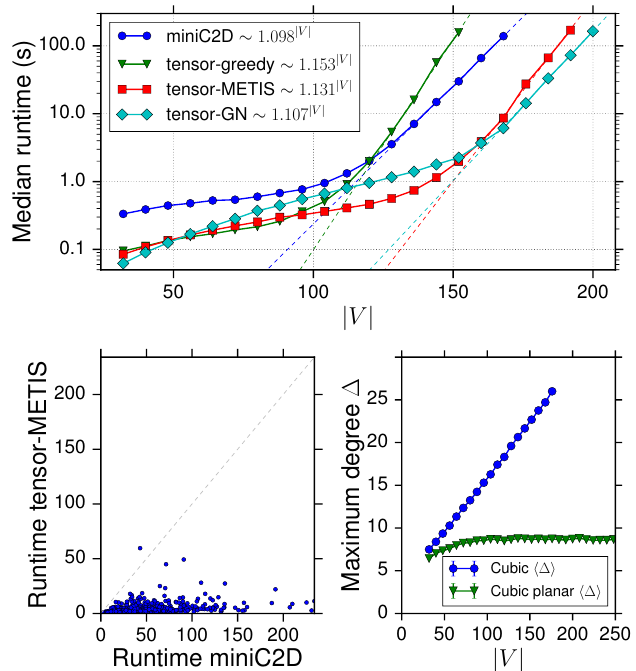
Figure 4: (a) Median runtime of tensor network contraction solvers and miniC2D for the solution of #C UBIC -V ERTEX -C OVER . All algorithms were run on the same ran- dom sample of 1000 instances of the problem. Dashed lines indicate the scaling extrapolated from the last 4 data points for each method. (b) Per instance runtime comparison between tensor-METIS and miniC2D for instances with 152 variables. Dashed gray line indicates equal runtime for the two algorithms. (c) Average max- imum degree ∆ encountered during the contraction sequence of tensor-METIS as a function of instance size for unrestricted (circles) vs planar (triangles) instances of #C UBIC -V ERTEX -C OVER . All calculations were performed on a single core of an AMD Opteron 6320 2800MHz processor with 64GB of RAM